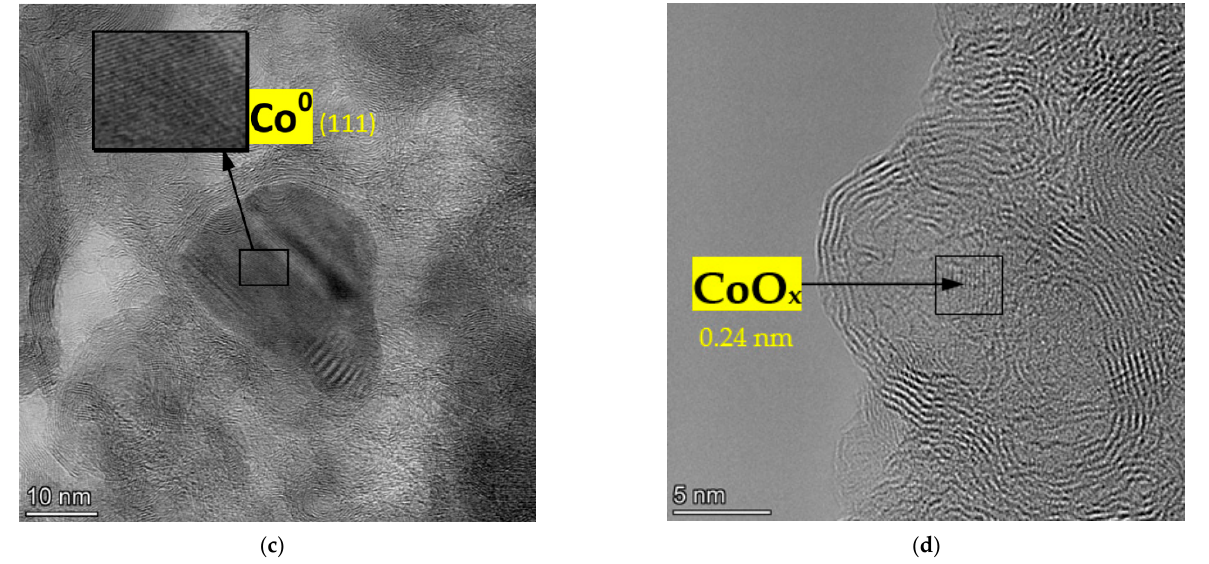
Figure 2. TEM images of Co@NC-ZIF SA : ( a ) general view; ( b ) a typical structural motif representing graphitic carbon; ( c ) cobalt residual nanoparticle densely coated with graphite carbon; ( d ) the fragment containing cobalt oxides.